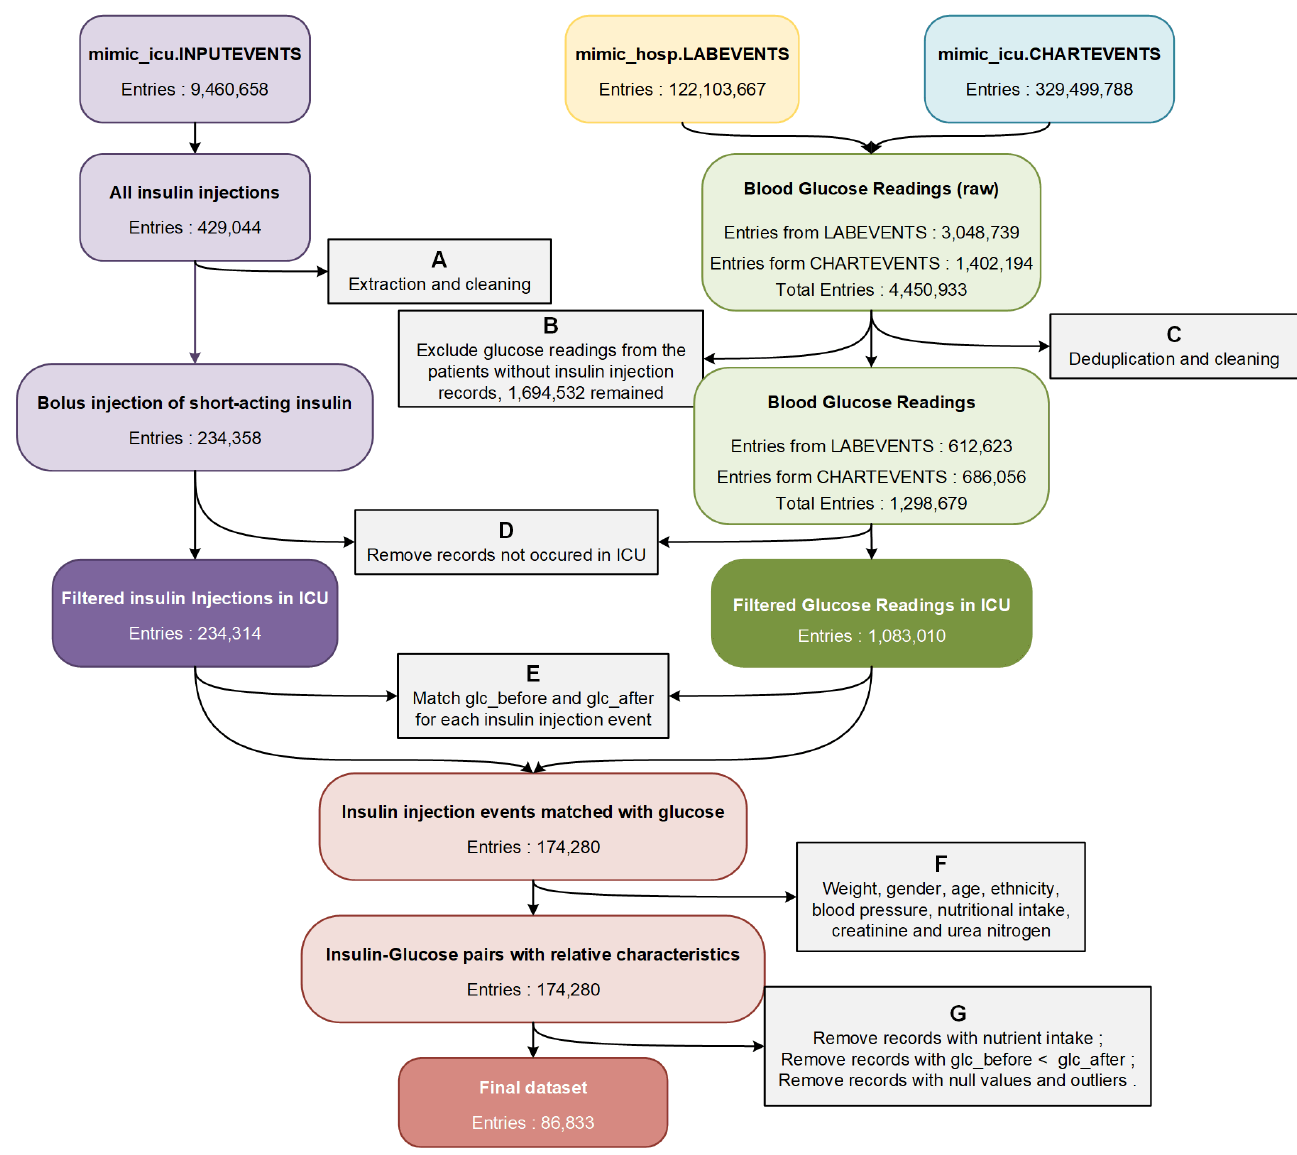
Figure 1. The overview process of dataset